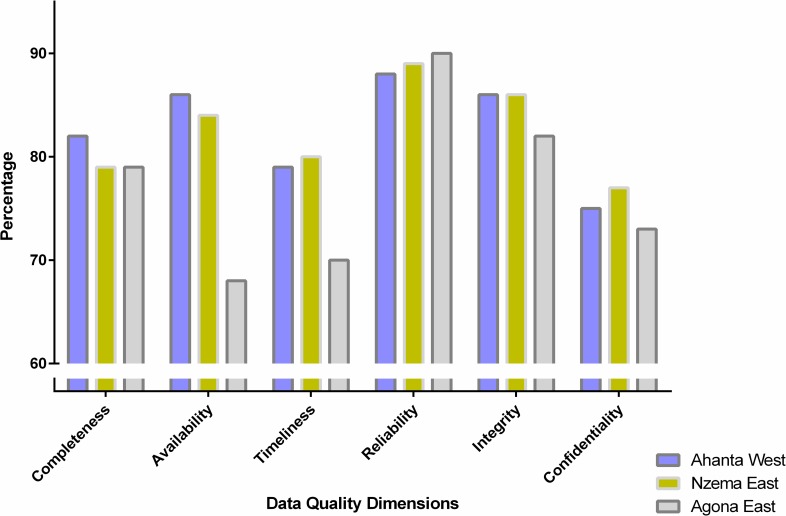
Data quality dimensions in study sites.Percentages indicate the score for each Data Quality Dimensions observed in the Districts.